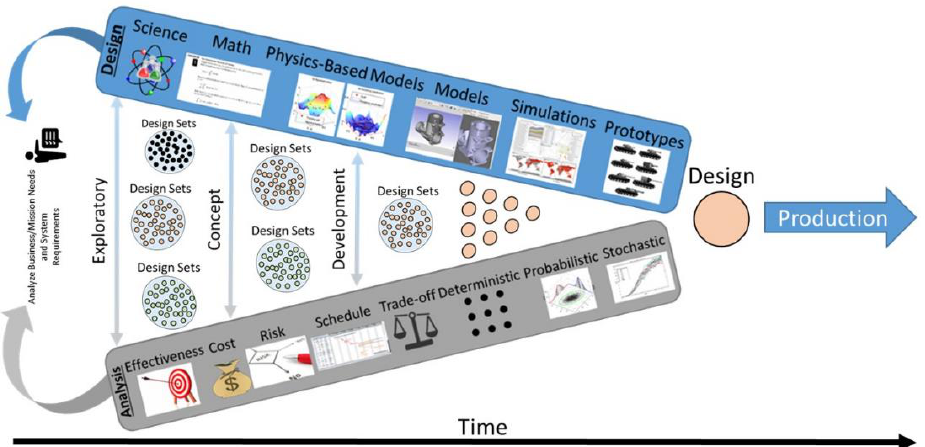
Figure 2. SBD Conceptual Framework for System Design.